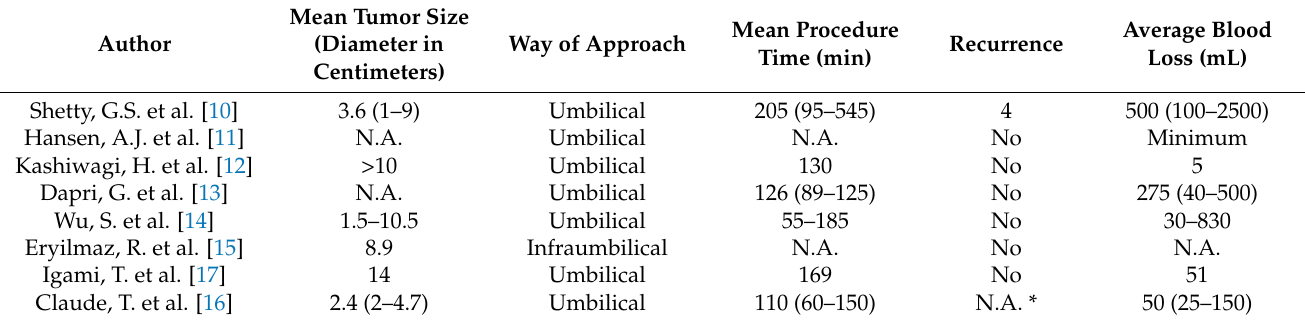
Table 5. SILS: analysis of intraoperative characteristics, approach and postoperative